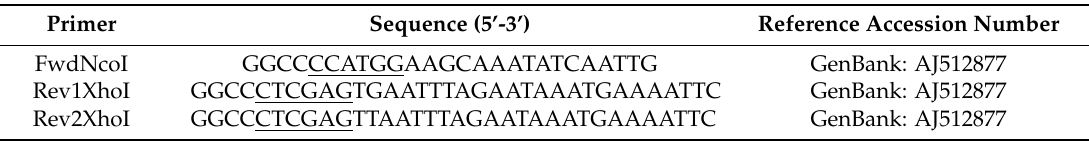
Table 5. Oligonucleotide primers used for amplification of β -galactosidase encoding genes lacLM